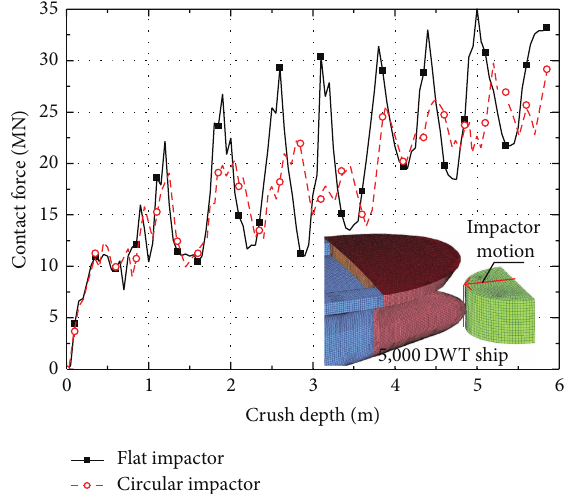
Figure 12: Comparison of P-a curves for different shape impactors. The numerical model of the flat impactor is shown in Figure 10(a) at the depth of ℎ = 4.0 m; the numerical model of circular impactor is presented in the above figure at ℎ = 4.0 m and the diameter of 9.4 m.